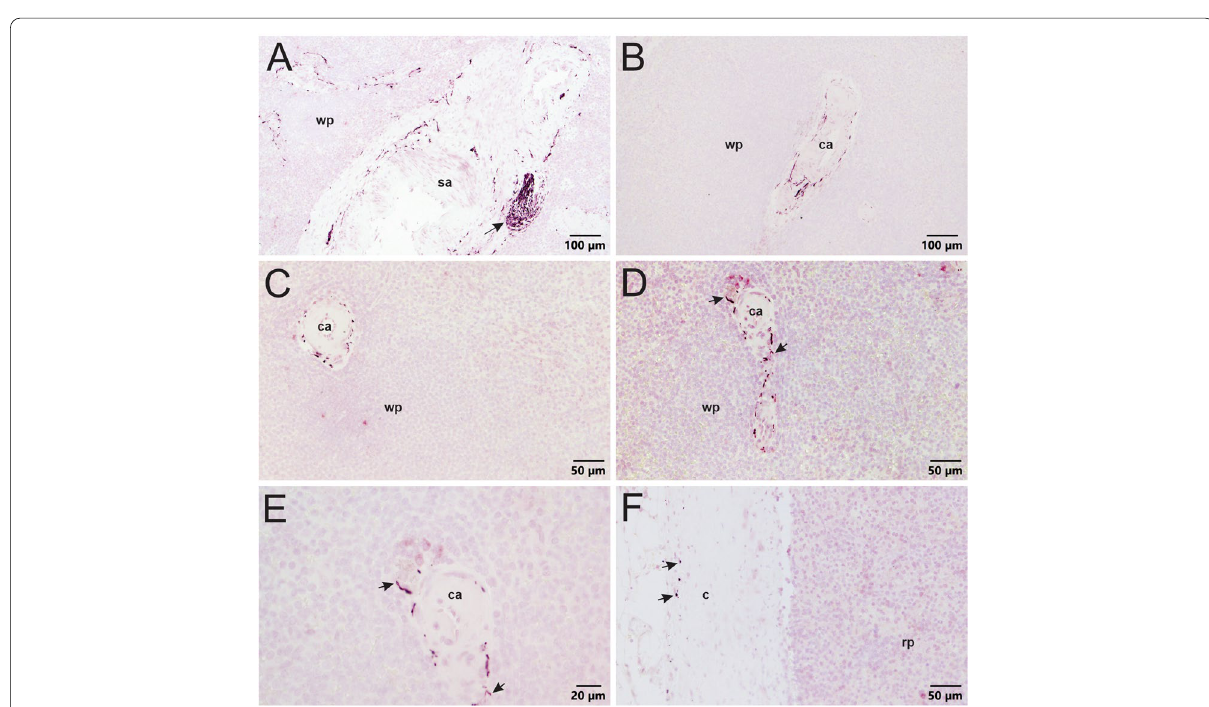
Fig. 2 TH innervation of normal human spleens using VIP chromogen and citrate buffer antigen retrieval. Sympathetic nerves were located + primarily in the adventitia surrounding blood vessels and only rarely extended into the white pulp (wp). A A longitudinal cut showing the splenic artery (sa) and sympathetic innervation within the surrounding adventitia. Arrow indicates a nerve bundle. B Sympathetic innervation of a moderate-sized central arteriole (ca.) within white pulp. C Higher magnification image of a smaller arteriole surrounded by nerves. D Sympathetic nerves run along a blood vessel cut longitudinally. Arrows indicate TH nerves extending a short distance into the surrounding white pulp. + E Higher magnification of same arteriole in panel D showing nerves (arrows) protruding into the white pulp. F Arrows indicate TH nerves cut in + cross-section within the capsule (c). Note the absence of innervation in the red pulp (rp) to the right